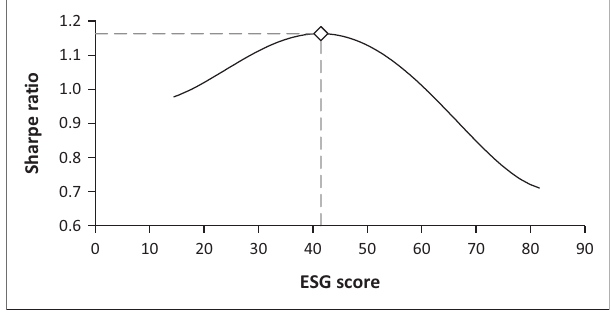
FIGURE 4: Sharpe ratio as a function of environmental, social and governance score for a portfolio of 30 South African